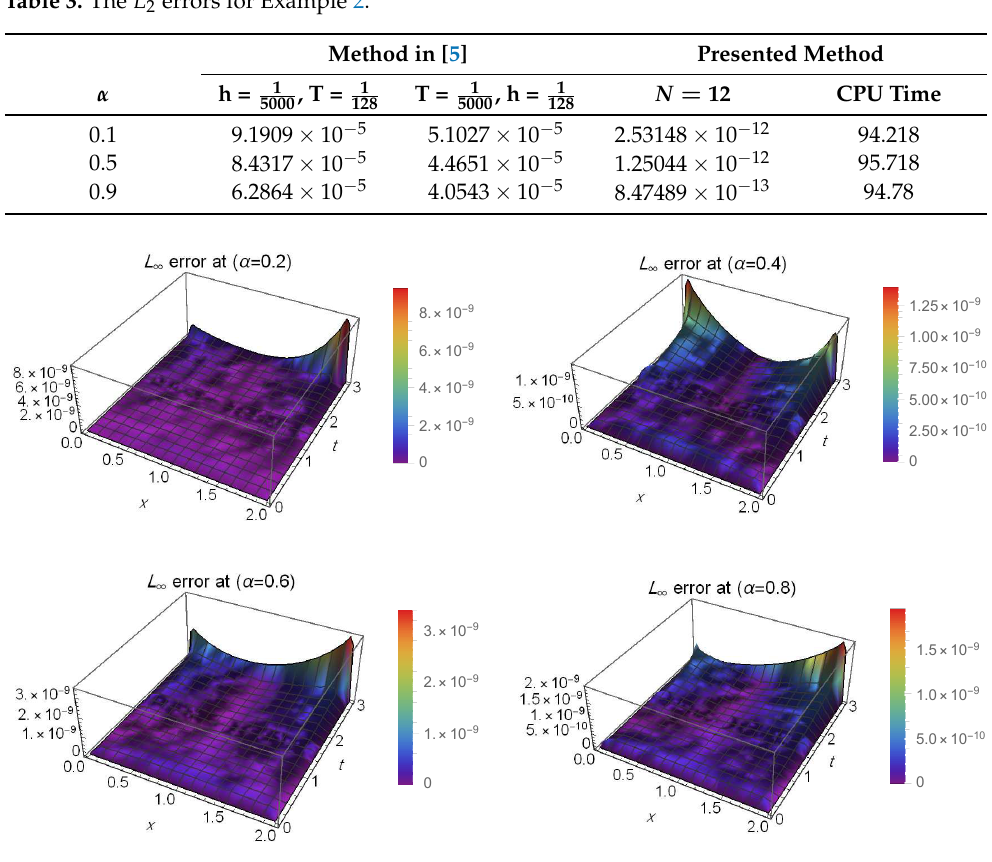
Figure 2. The L ∞ error for Example